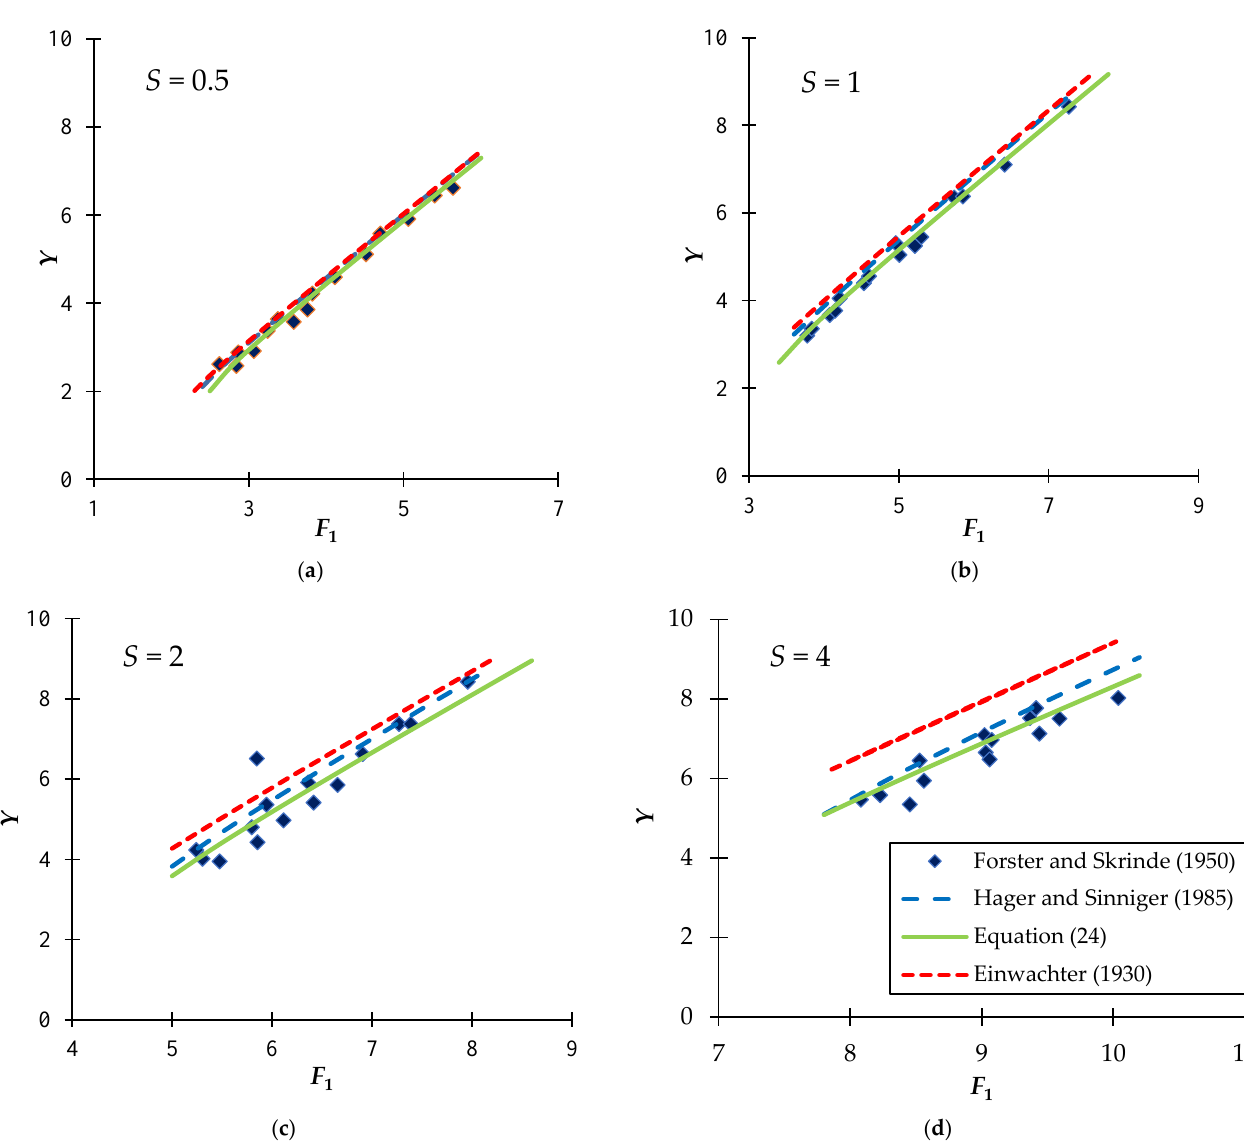
Figure 5. Curvature correction coefficient variation with initial Froude number.